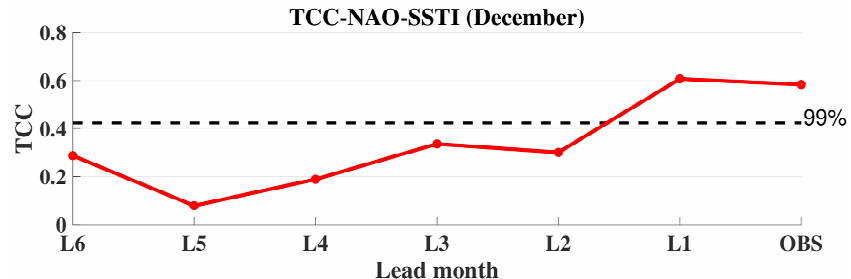
Figure 4. TCCs between the NAO and SSTA tripole index in December. L6–L1 refer to the CFSv2-predicted TCCs for initial months from June to November. OBS means the observed TCCs in December, January, and February. The black lines indicate statistical significance at the 99% confidence level, as estimated by a local Student’s t -test.